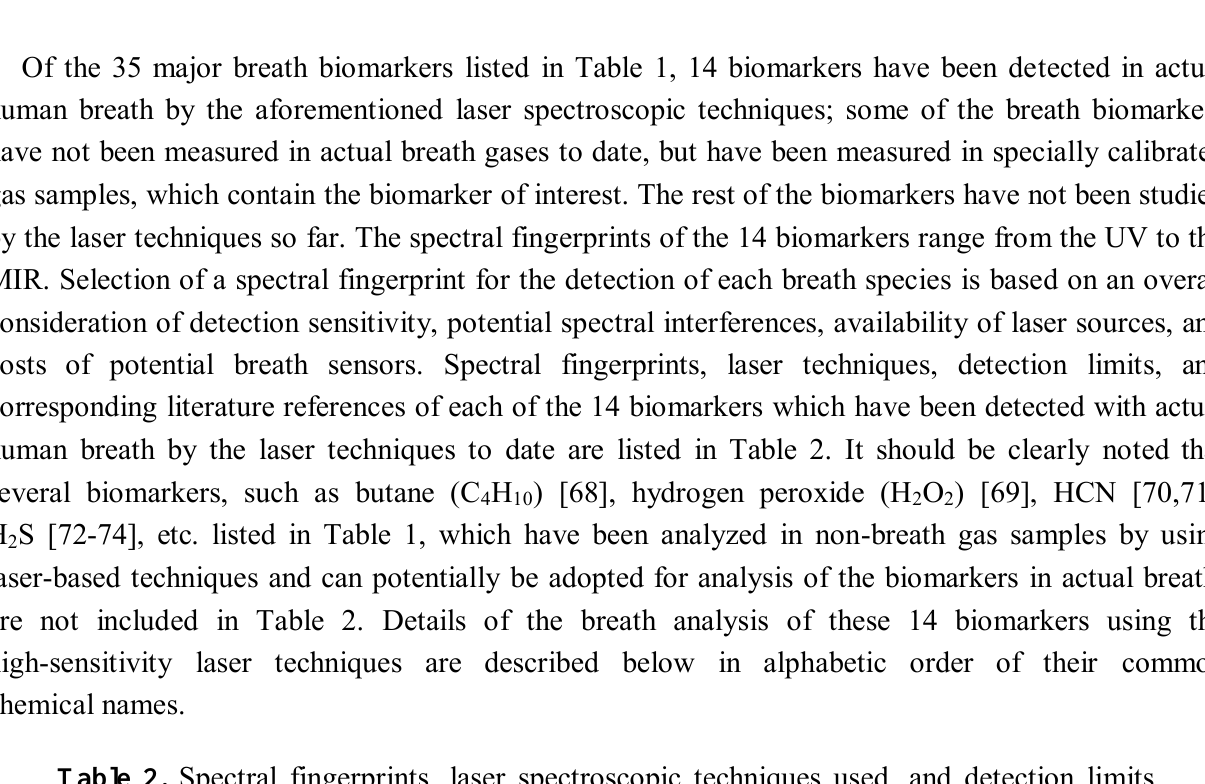
Table 2. Spectral fingerprints, laser spectroscopic techniques used, and detection limits achieved for the 14 major biomarkers, which have been analyzed with actual human breath by the laser spectroscopic techniques. The numbers in the parenthesis in the Column 4 indicate the measuring times in which the corresponding detection limits were